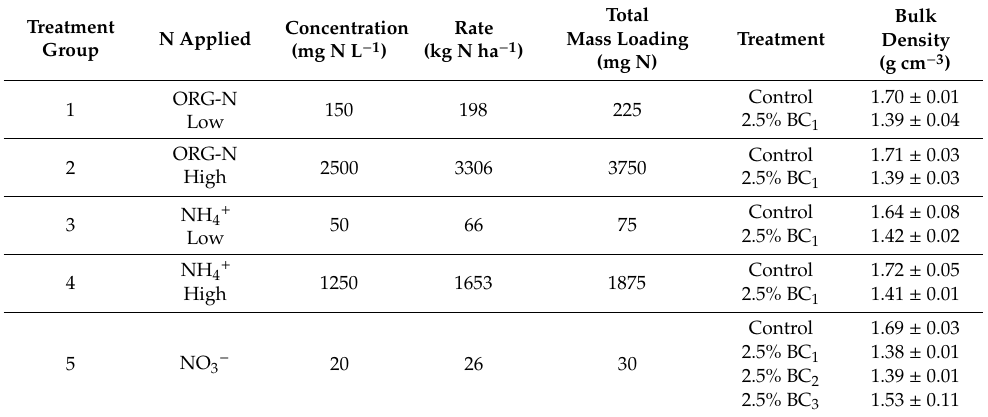
Table 1. Study experimental design setup, weekly application concentrations, weekly application rates, total mass loading, and average column soil bulk